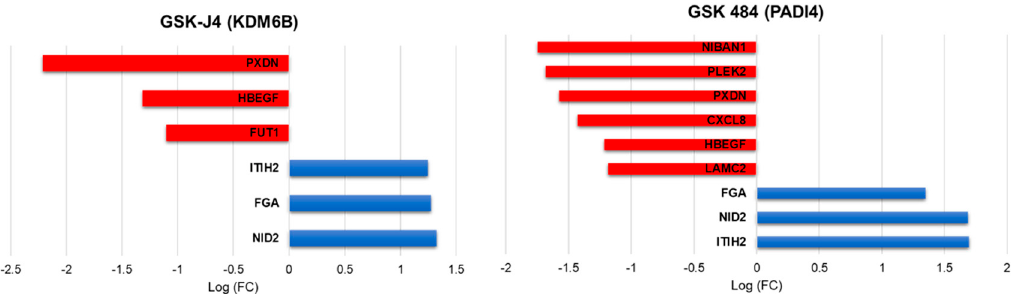
Figure 3. Representation of log-fold change value of EMT-related gene regulation after treatment with PADI4 and KDM6B inhibitors.